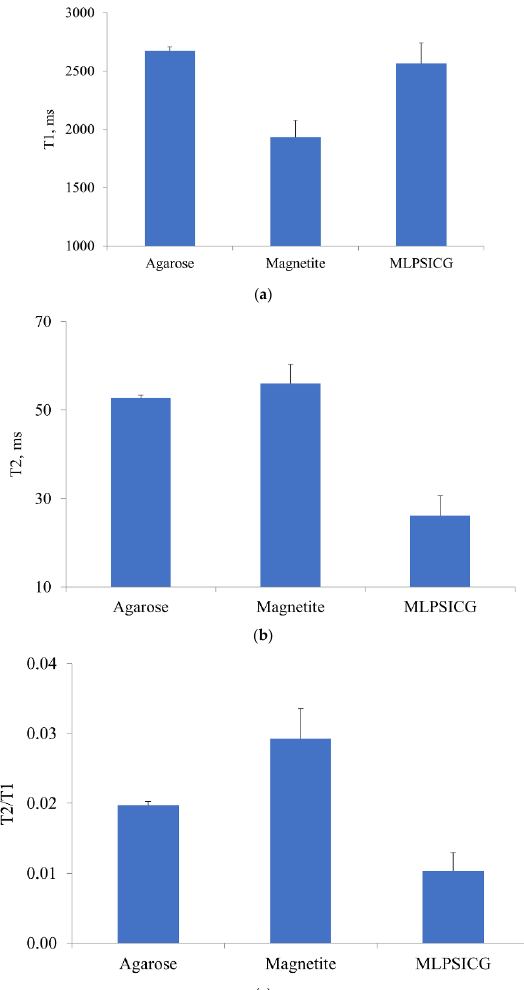
Figure 4. Magnetic resonance contrast properties of samples. T 1 and T 2 values, as well as the T 2 /T 1 ratio, were determined using NMR spectrometry in pure 1.0% agarose matrix blocks, MNP-containing blocks, and MLPSICG-containing blocks: ( a ) T1; ( b ) T2; ( c ) T2/T1 ratio.